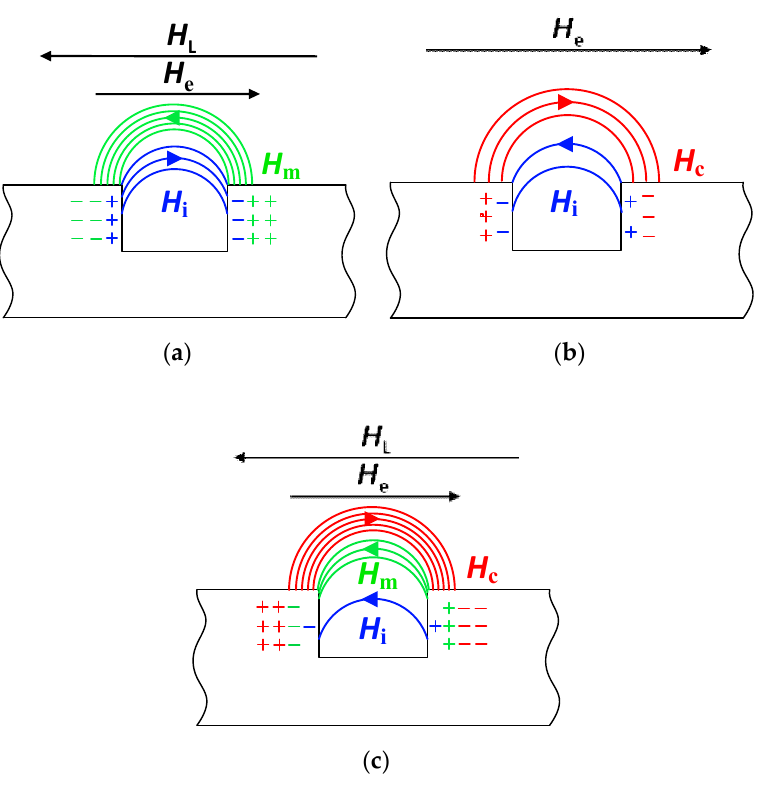
Figure 12. Schematic diagram of MFL signals in three experiments: ( a ) experiment 1 (static tensile); ( b ) experiment 2 (corrosion without loading); ( c ) experiment 3 (corrosion after loading).